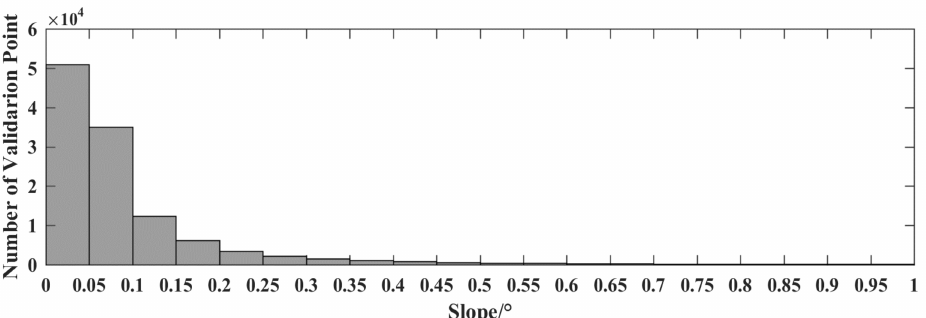
Figure 12. Number of OIB airborne points used to ICESat-2 RIS DEM evaluation. The horizontal coordinate is the slope of the surface from 0 ◦ to 1 ◦ with an interval of 0.05 ◦